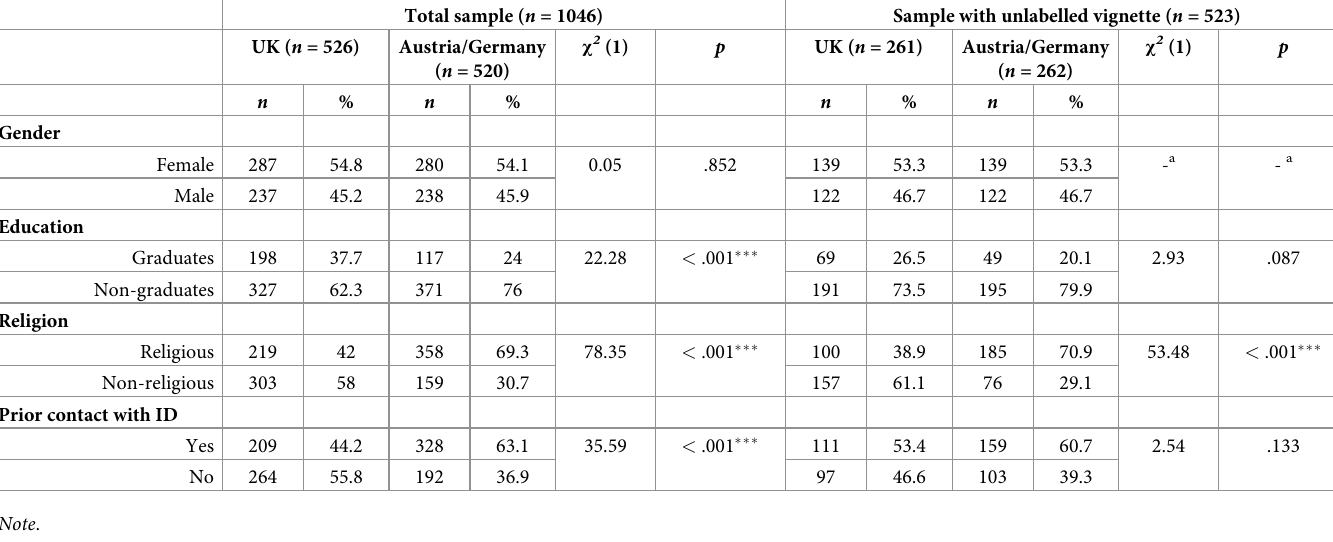
Table 1. Sociodemographic characteristics and results of χ 2-tests for differences between Austria/Germany and UK.